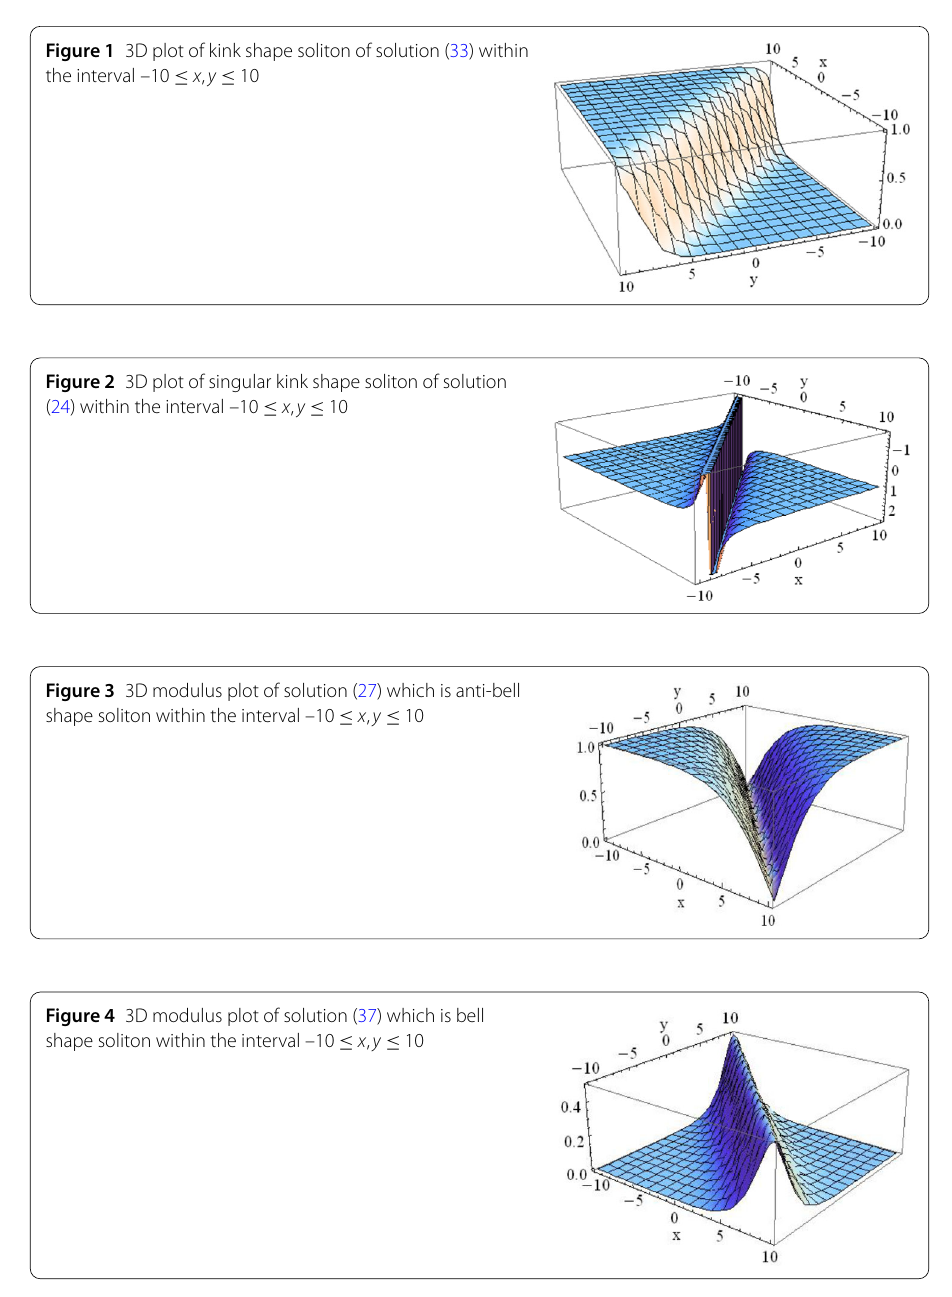
Figure 1 3D plot of kink shape soliton of solution (33) within the interval –10 ≤ x , y ≤ 10